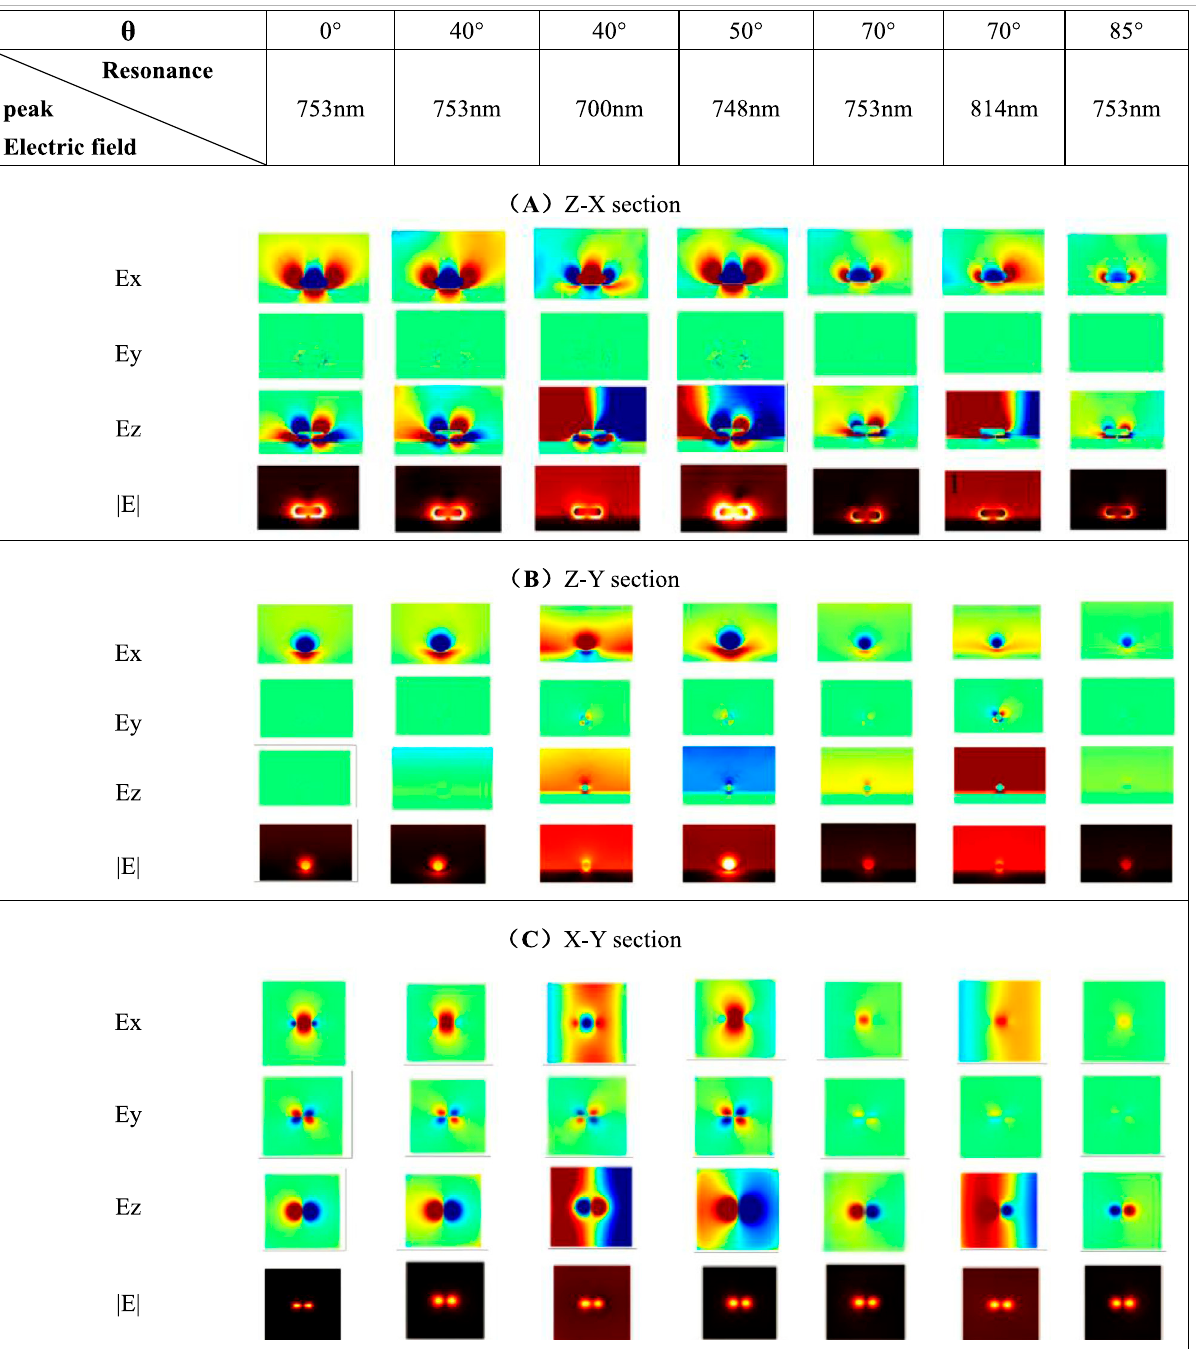
TABLE 4 | Electric fi eld cross-section at different incident